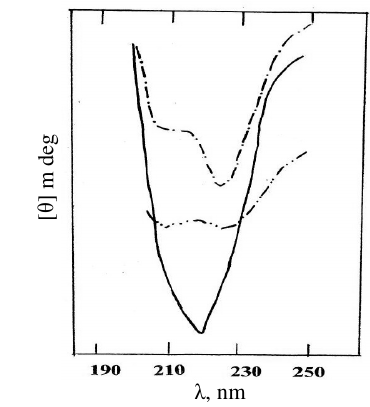
Figure 1. IR Spectra of γ - benzyl- L - glutamate and L - valine copolypeptides, - ; n=13, - - ; n= 30, - . - ; n = 45.